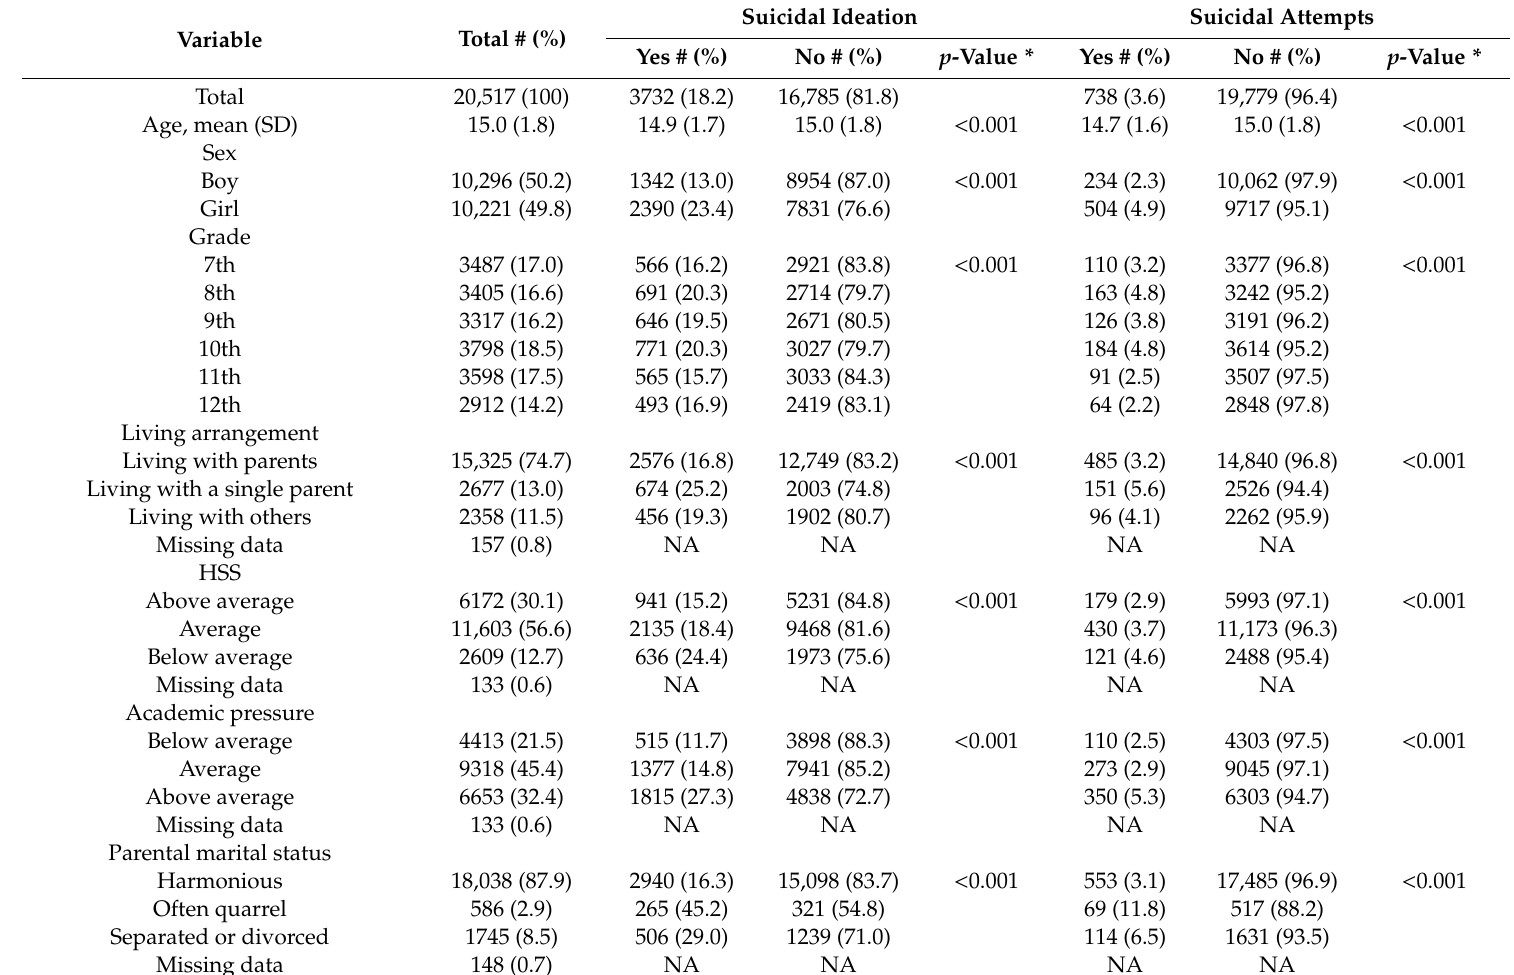
Table 1. Sample characteristics of 20,517